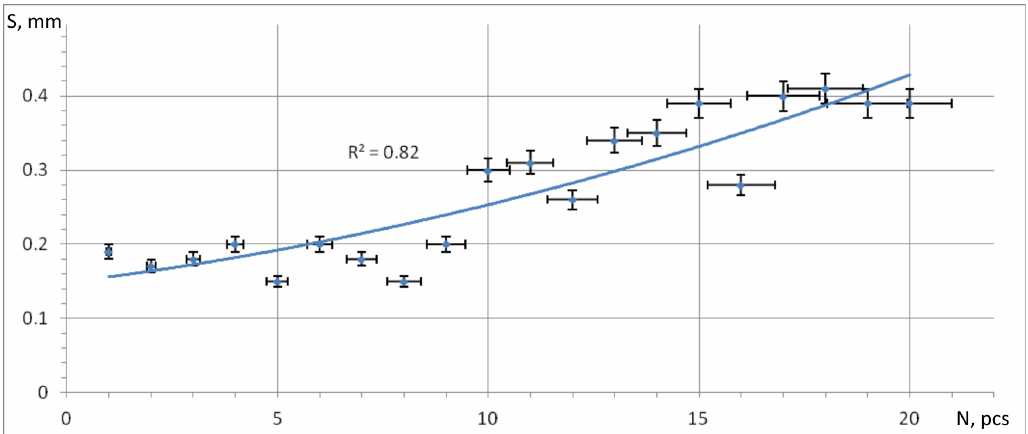
Figure 7. Change in the wear value, S, of wheel thrust washers depending on the location of the stage of the pumping section in the direction of the water–abrasive mixture flow.